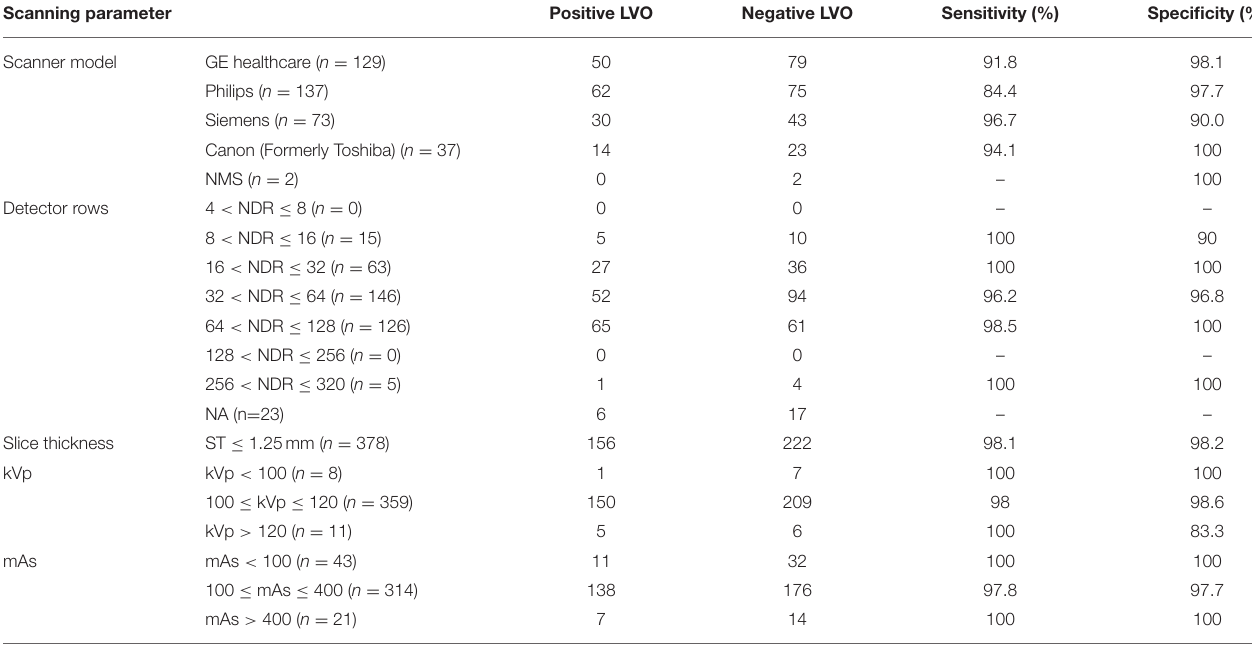
TABLE 9 | Performance metrics for LVO cases based on different scanning